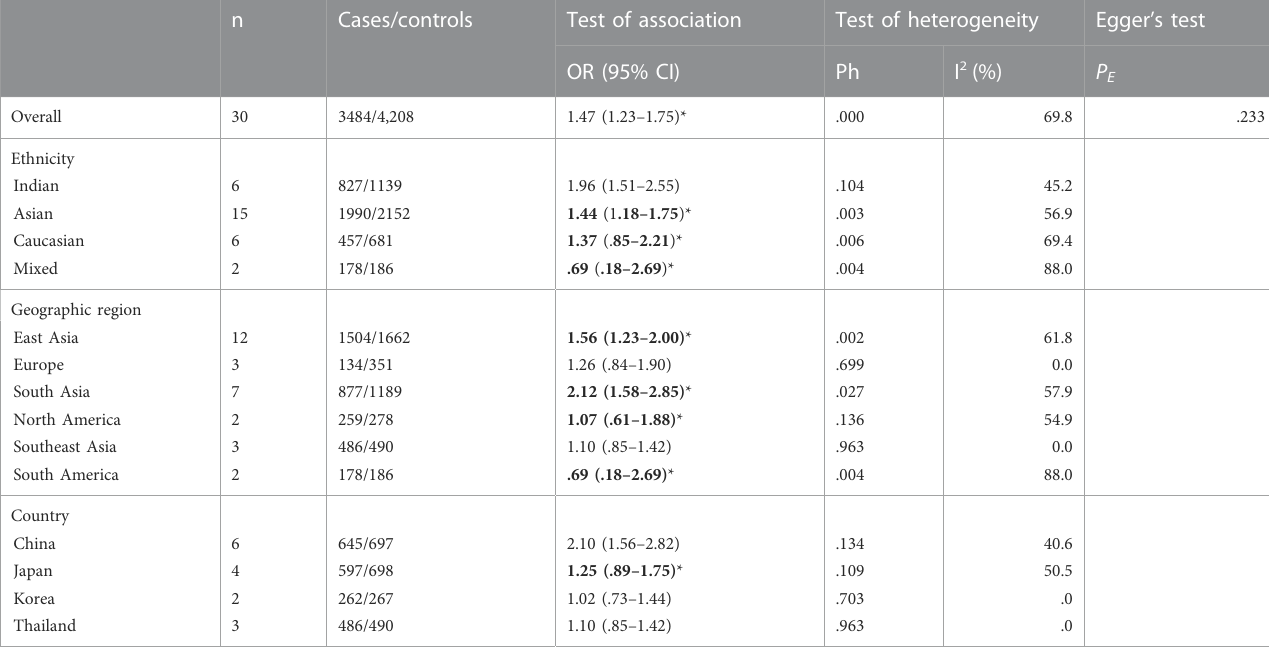
TABLE 4 Pooled estimates of the association of GSTM1 polymorphism with risk of cervical cancer.